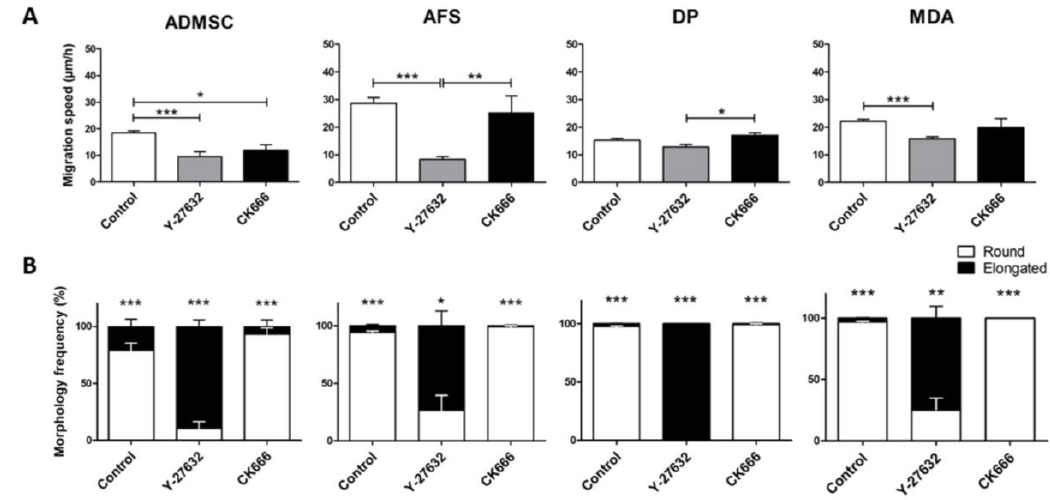
Figure 3. Examining the activity of ROCK and Arp2/3 in cell migration and morphologies. ( A ) Effect of inhibiting ROCK (Y-27632) and Arp2/3 (CK666) on cell migration on muscle myofibres; ( B ) Effect of inhibiting ROCK (Y-27632) and Arp2/3 (CK666) on cell morphology frequencies. In all conditions n ≥ 15 myofibres examined. One-way ANOVA ( A ), individual Student’s t -tests ( B ), * p < 0.05, ** p < 0.01, *** p < 0.001. In ( B ) statistical differences indicated between proportion of rounded and elongated cell numbers.